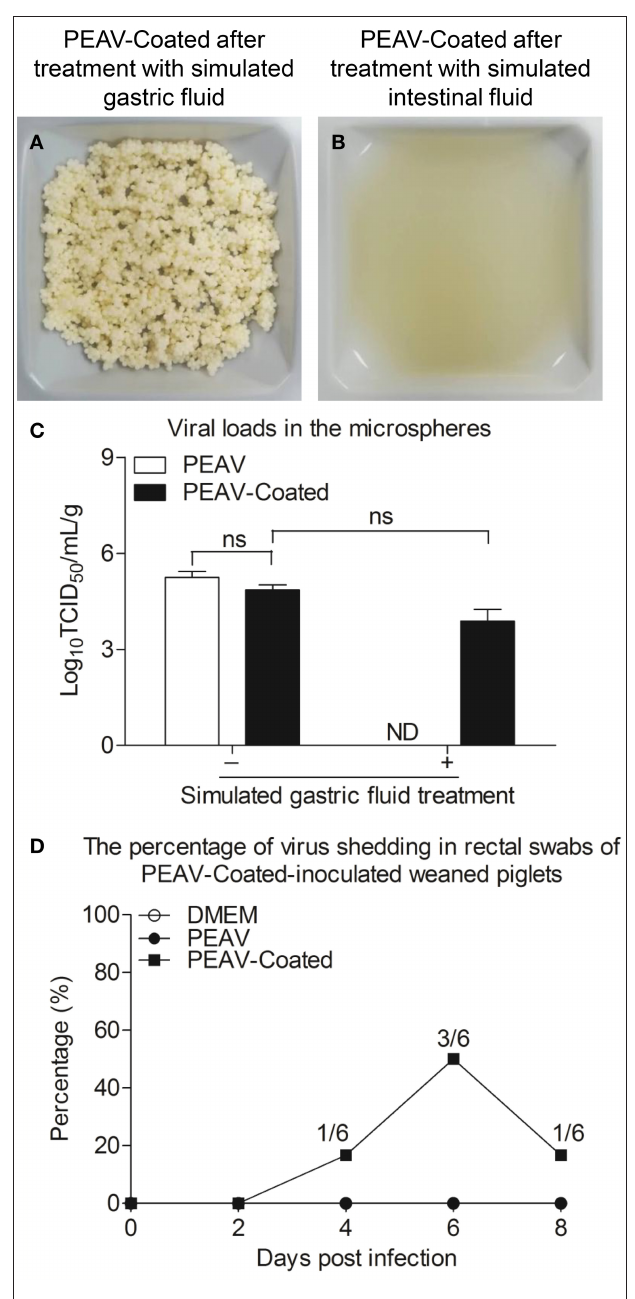
FIGURE 3 | Acid resistance and dissolvability of the PEAV-Coated in intestinal fluid in vitro and in vivo . PEAV-Coated were treated with the simulated gastric fluid (A) and the simulated intestinal fluid (B) . The acid resistance of the PEAV-Coated was analyzed before and after the simulated gastric fluid treatment by a TCID 50 assay, and PEAV was treated and analyzed equally as the control (C) . Weaned piglets were orally inoculated with PEAV-Coated, PEAV, and maintenance medium. Rectal swabs were collected from the piglets on days 0, 2, 4, 6, and 8 post inoculation and the virus shedding of PEAV were examined through real-time PCR using specific primers. The percentage of PEAV infection was calculated in (D) . Results of TCID 50 are representative of three independent experiments. Data are represented as mean ± SD, n = 3. ND means non-detectable.